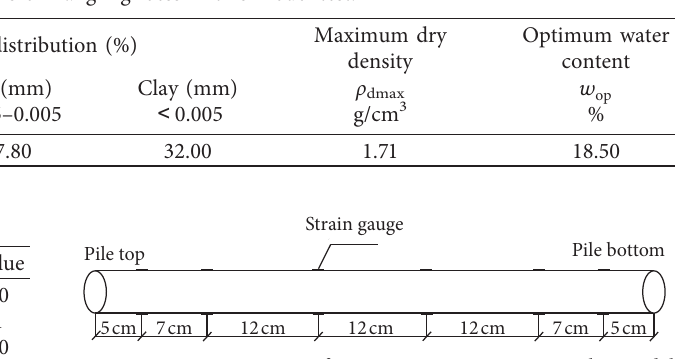
Figure 1: Arrangements of resistance strain gages on the model